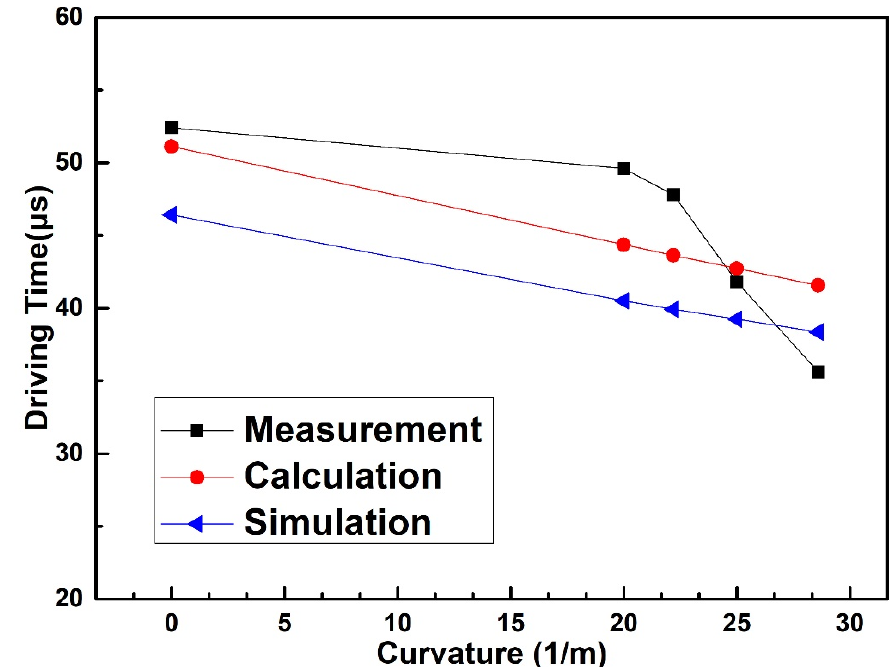
Figure 11. Measured driving time of the spring-like double-clamped beam switch with different substrate curvatures.